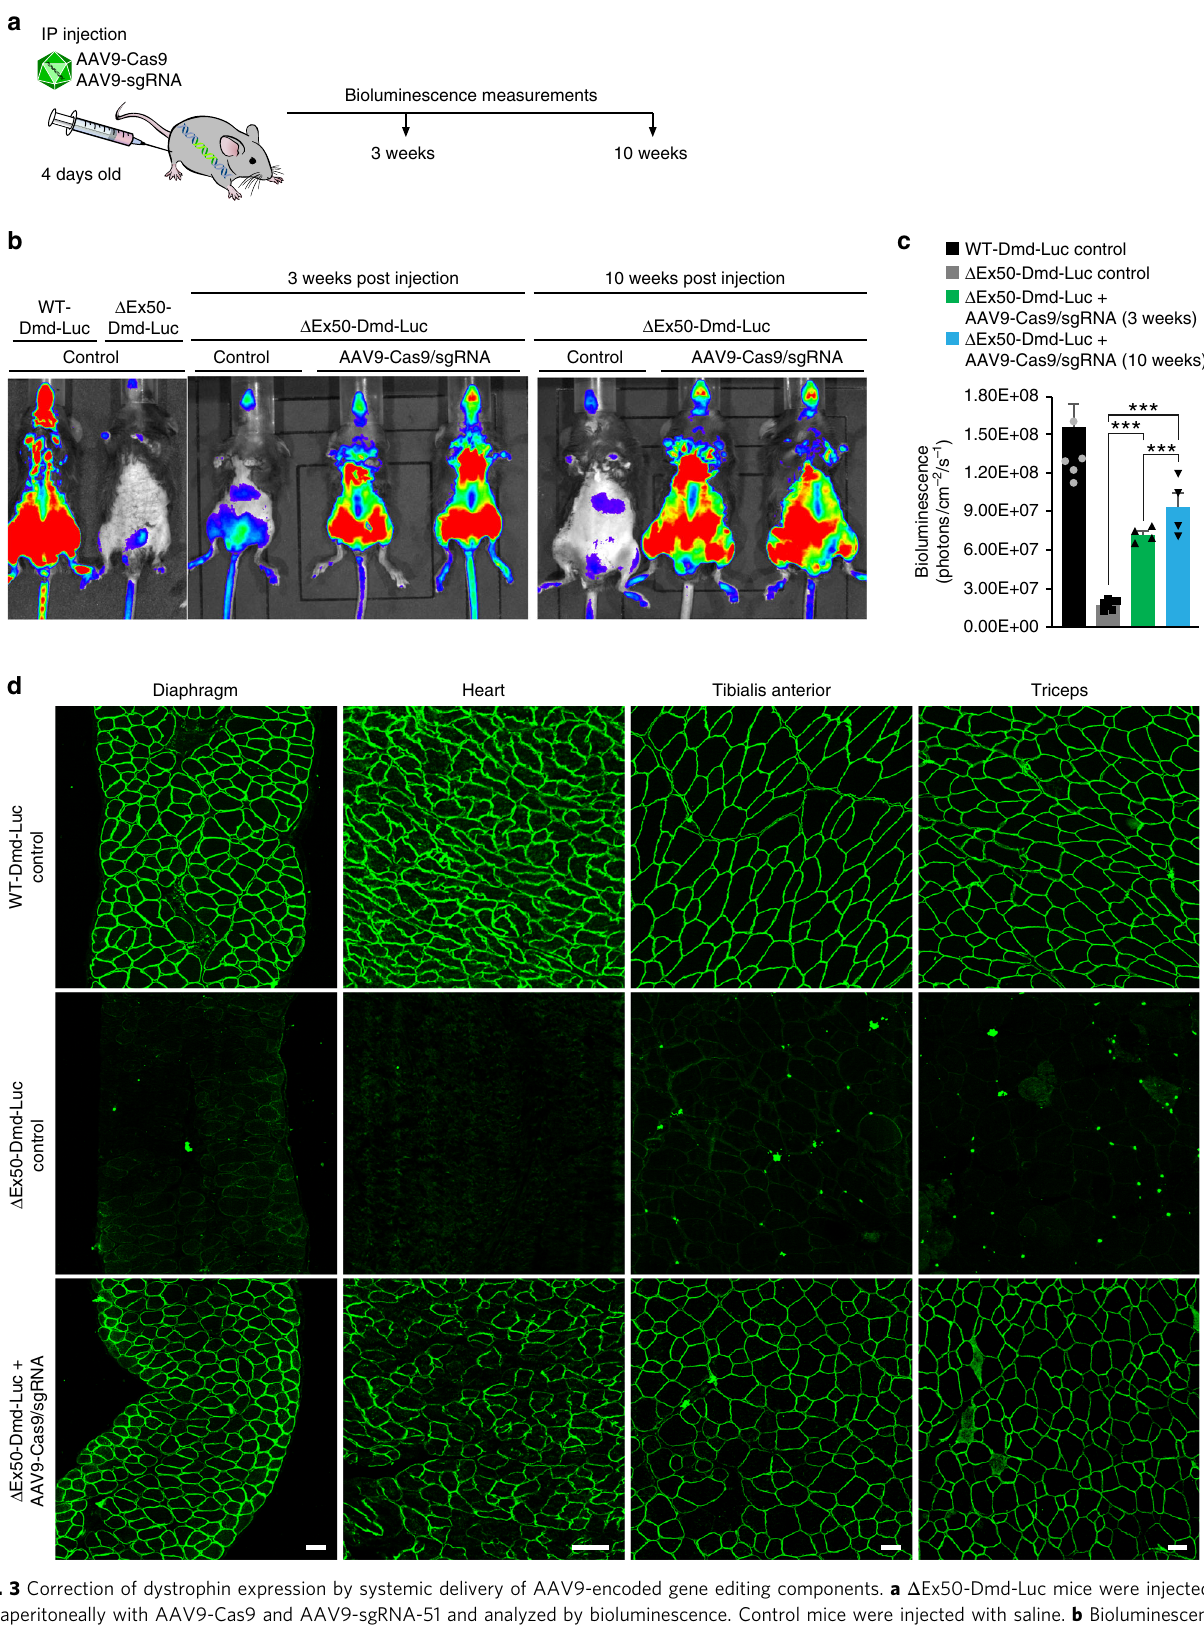
Fig. 3 Correction of dystrophin expression by systemic delivery of AAV9-encoded gene editing components. a Δ Ex50-Dmd-Luc mice were injected intraperitoneally with AAV9-Cas9 and AAV9-sgRNA-51 and analyzed by bioluminescence. Control mice were injected with saline. b Bioluminescence imaging of WT-Dmd-Luc mice and Δ Ex50-Dmd-Luc mice injected with AAV9-Cas9 and AAV9-sgRNA. c Bioluminescent imaging (BLI) measurements of WT-Dmd-Luc mice, control Δ Ex50-Dmd-Luc mice and Δ Ex50-Dmd-Luc mice injected with AAV9-Cas9 and AAV9-sgRNA. d Dystrophin immunohistochemistry of diaphragm, heart, tibialis anterior, and triceps muscles 10 weeks after systemic injection with AAV9-Cas9 and AAV9-sgRNA. Data are represented as mean ± SEM. n = 4. ( *** P < 0.0005). Scale bar: 50 μ